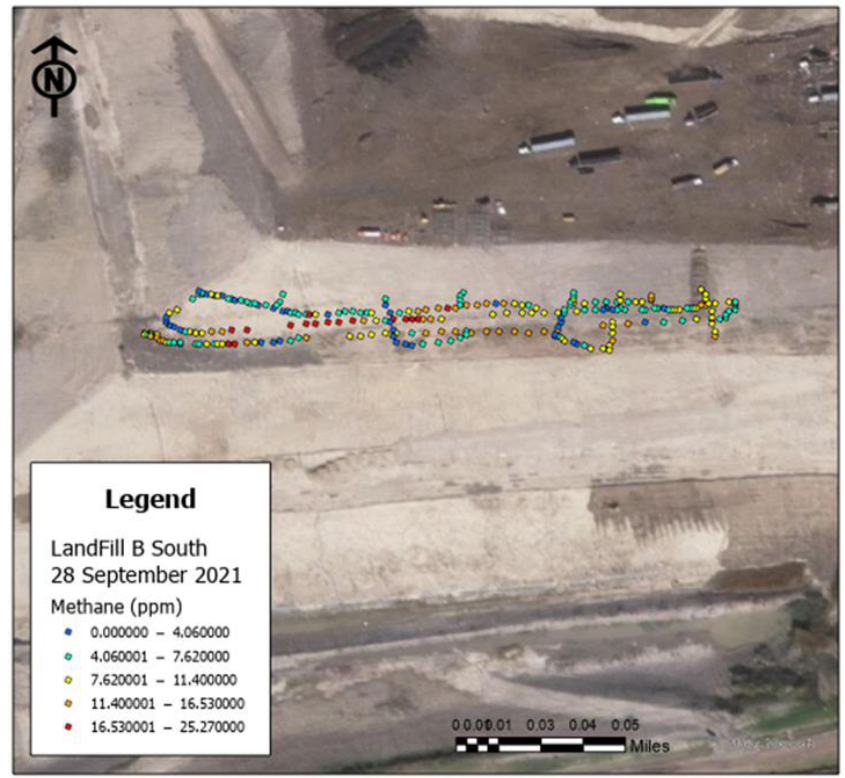
Figure 15. DR1000 measurements of methane for the Southern Flux Plane at Facility B on 28 September 2021.